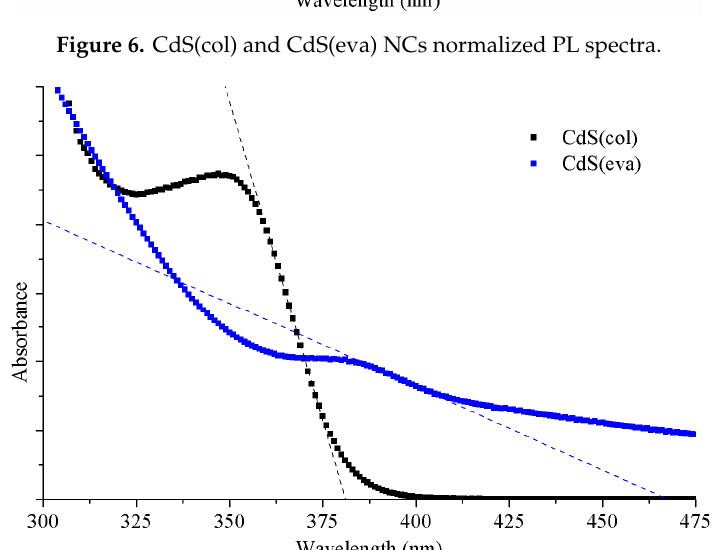
Figure 7. CdS(col) NCs (black) in DMSO and CdS(eva) NCs (blue) in toluene absorbance spectra.